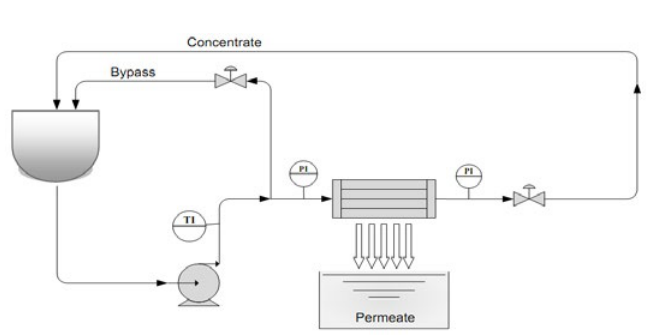
Fig. 1. Schematic depiction of nanofiltration setup